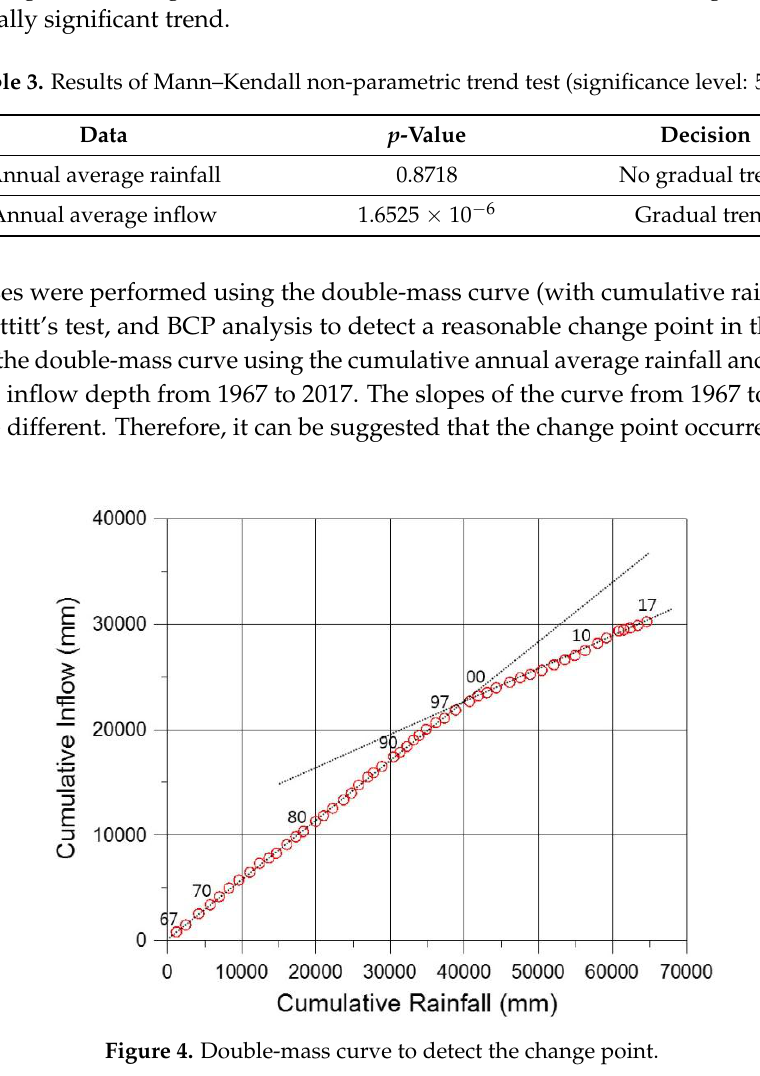
Table 4. Results of Pettitt’s test (significance level: 5%). Data